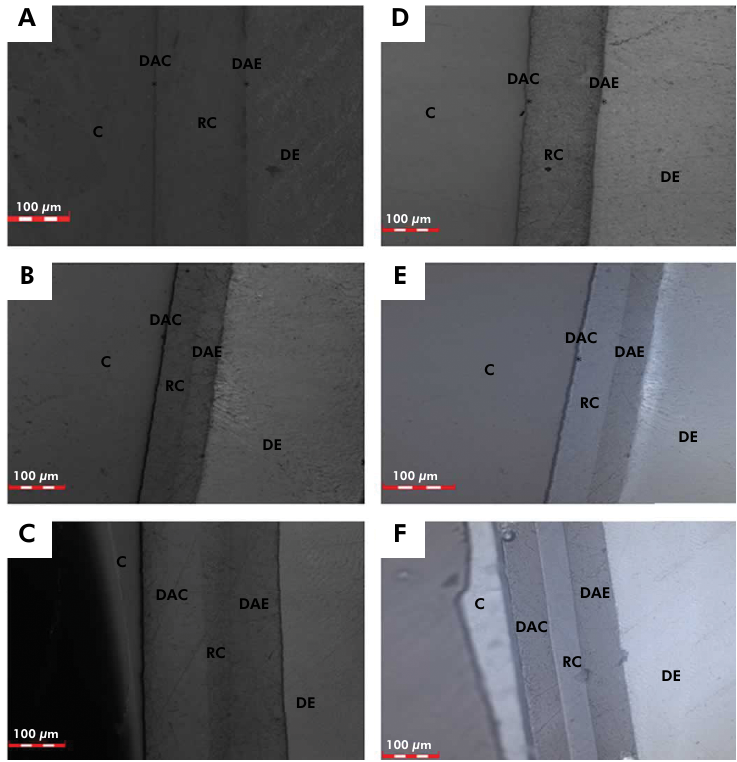
Figure. A. Adhesive interface of Single Bond Universal/RelyX Veneer luting materials with no prior dental adhesive photoactivation. B. Adhesive interface of Single Bond Universal/RelyX Veneer luting materials undergoing prior dental adhesive photoactivation on the dental enamel. C. Adhesive interface of Single Bond Universal/RelyX Veneer luting materials undergoing prior dental adhesive photoactivation on the dental enamel and inner surface of ceramic substrate. D. Adhesive interface of Tetric N Bond/Variolink Veneer luting materials with no prior dental adhesive photoactivation. E. Adhesive interface of Tetric N Bond/Variolink Veneer luting materials undergoing prior dental adhesive photoactivation on the dental enamel. F. Adhesive interface of Tetric N Bond/Variolink Veneer luting materials undergoing prior dental adhesive photoactivation on the dental enamel and inner surface of ceramic